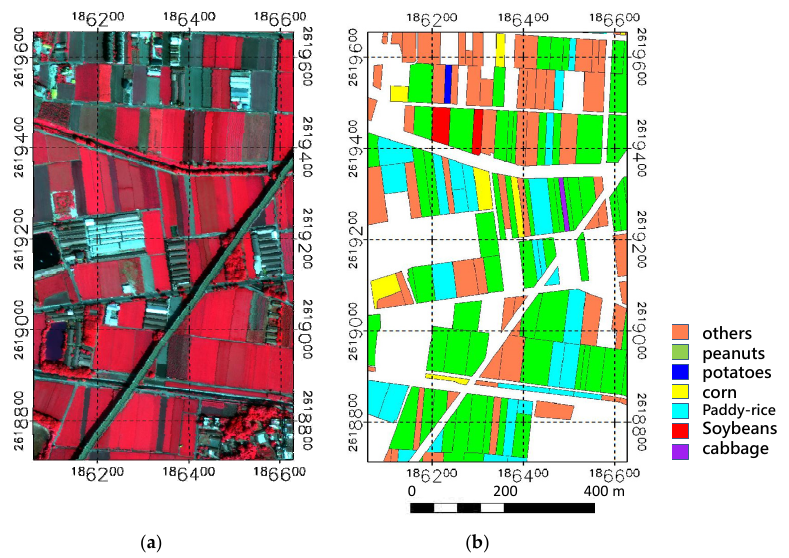
Figure 1. Study area. ( a ) Hyperspectrum image (April, 2016). ( b ) Ground truth data.